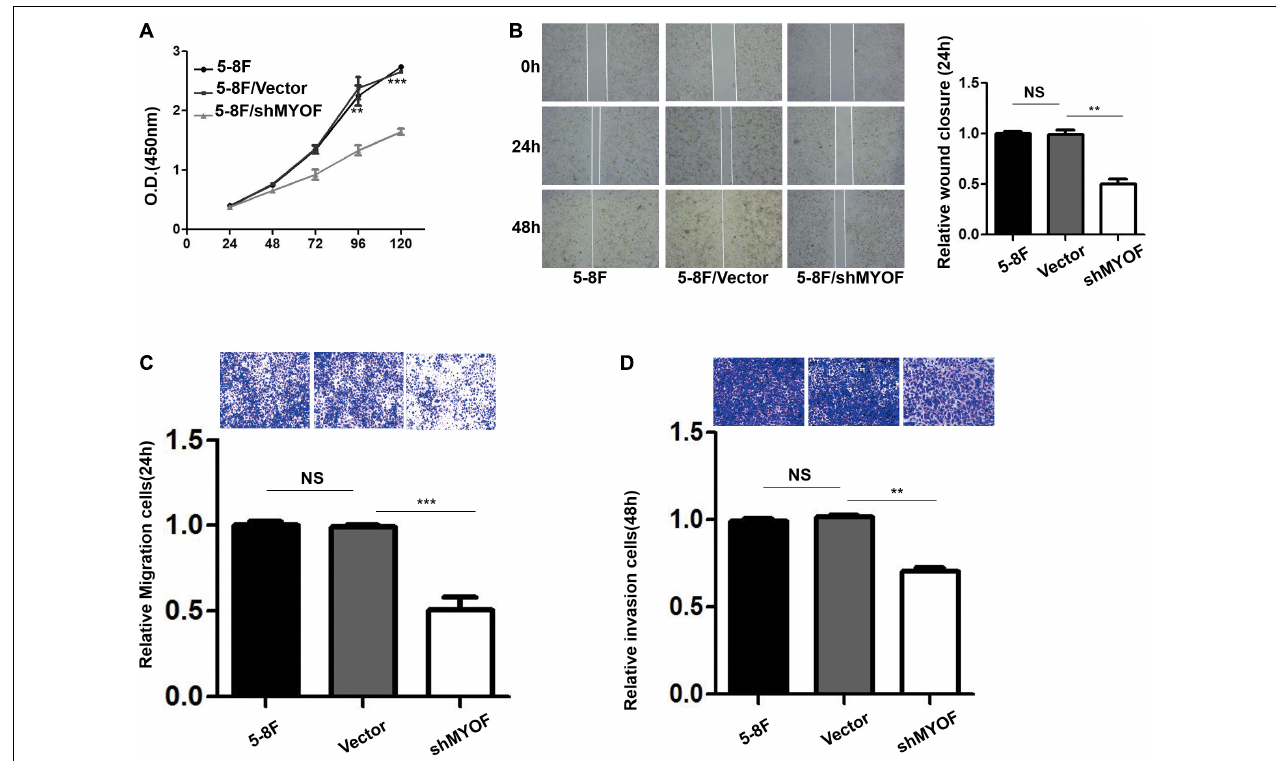
FIGURE 4 | MYOF silencing reduces the malignant phenotype of 5-8F cells. (A) Cellular proliferation of control and MYOF knockdown 5-8F cells when passaged for the indicated days. Independent experiments performed in triplicate (** p < 0.01 and *** p < 0.001, respectively, Students t -test). (B) Wound-healing assay performed with Vector- or shMYOF-transfected 5-8F cells. Representative images acquired at the indicated time points are shown. The unhealed area was measured in three independent experiments (** p -value < 0.01). (C) Control or MYOF knockdown 5-8F cells were subjected to Transwell migration assays in three independent experiments. Migratory cells were counted under a microscope (** p < 0.01). (D) Control or MYOF knockdown 5-8F cells were subjected to Transwell invasion assays (with Matrigel). Invasive cells were counted under a microscope (** p < 0.01).